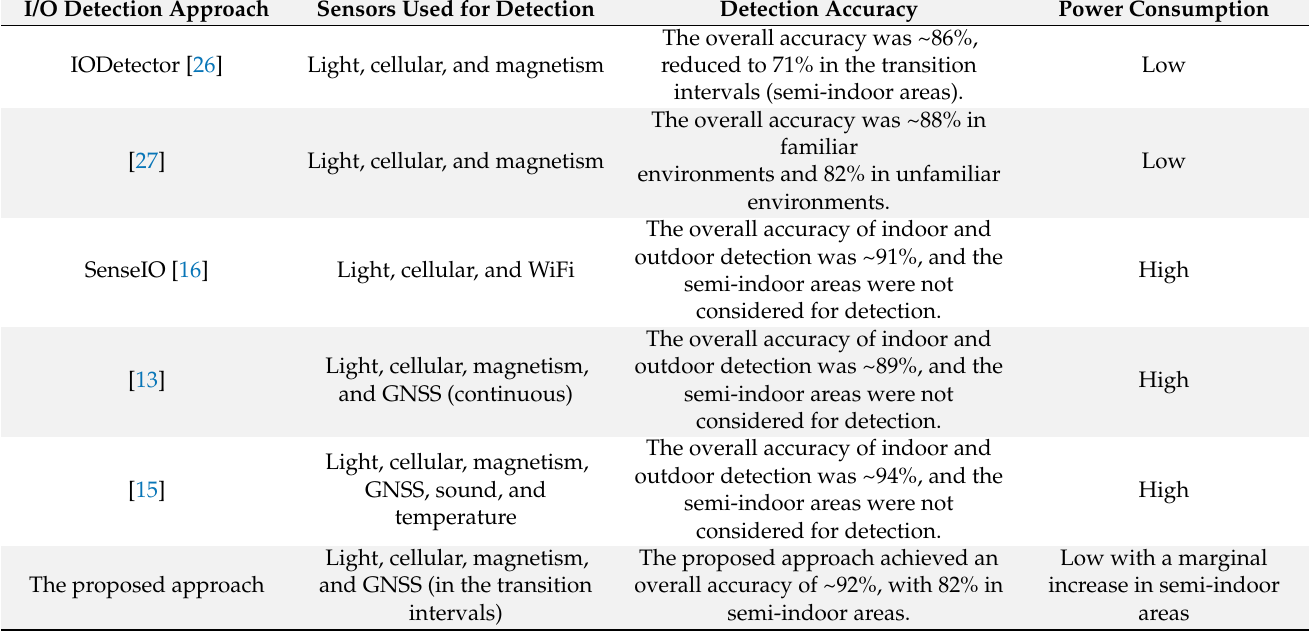
Table 3. Comparison between the performance of the proposed I/O detection and its counterparts. I/O Detection